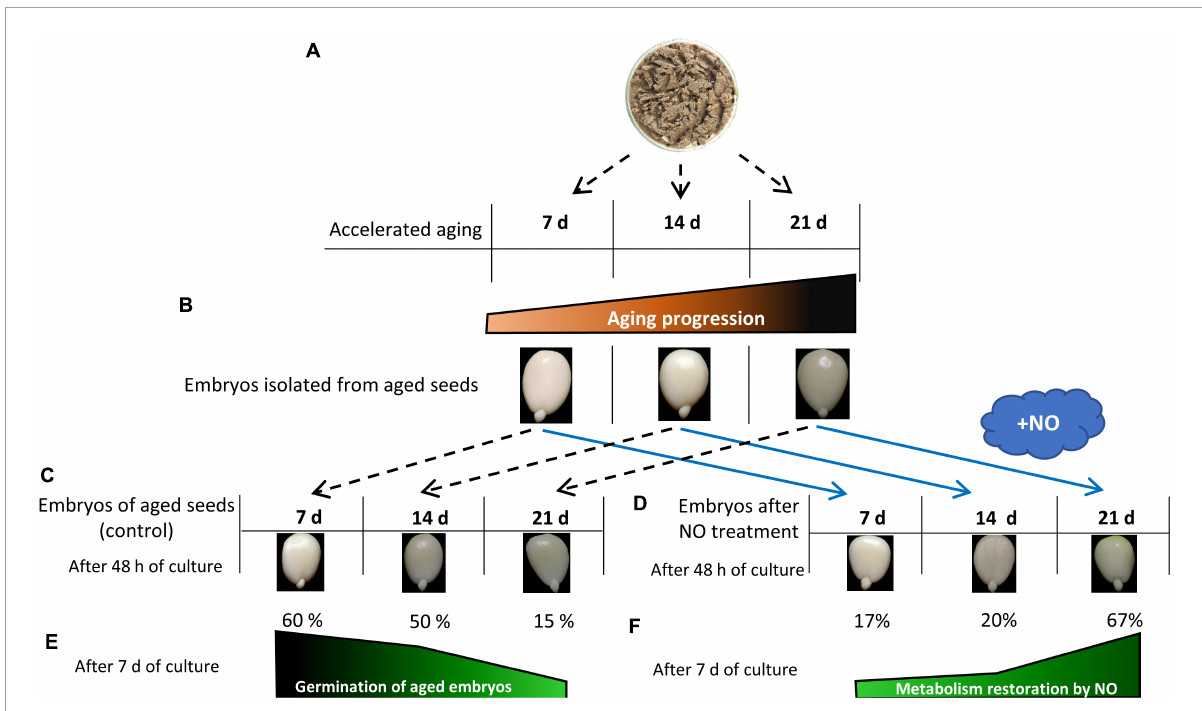
FIGURE7 The diagram describes the basic features of the biological material and the scheme of the experiment. Apple seeds were subjected to accelerated aging for 7, 14, or 21 days (A) . After seed aging embryos were isolated (B) . The typical embryos isolated from aged seeds [control (C) ] and the typical NO-treated embryos after 48 h of culture are shown panel (D) . Progression of seed aging was linked to the gradual decrease in germination rate of the embryos after 7 and 14 days, and a drop-down in the germination of the embryos as the aging lasted for 21 days (E) . NO acted as a remedy against aging by the increase in germination rate of the embryos isolated from aged seeds [metabolism restoration (F) ]. Metabolism restoration (%) was calculated based on the germination rate of the embryos after NO fumigation according to data presented by Ciacka et al. (2022). Embryos isolated from aged seeds and after NO treatment were viable (as indicated by the TTC test) as described by Ciacka et al.